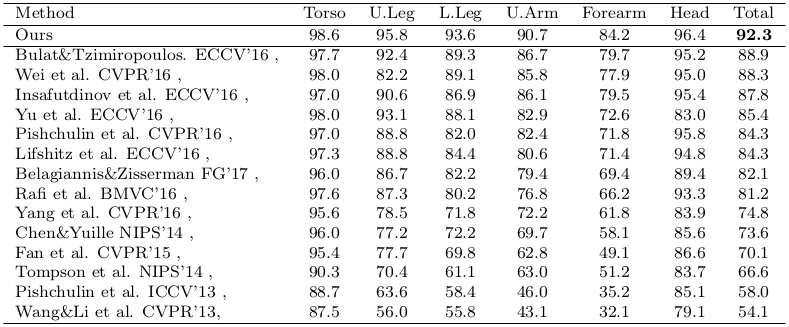
Table from the paper: Knowledge-Guided Deep Fractal Neural Networks for Human Pose Estimation
Table text:
Method
Torso
U.Leg
L.Leg
U.Arm
Forearm
Head
Total
Ours
98.6
95.8
93.6
90.7
84.2
96.4
92.3
Bulat&Tzimiropoulos. ECCV’16 ,
97.7
92.4
89.3
86.7
79.7
95.2
88.9
Wei et al. CVPR’16 ,
98.0
82.2
89.1
85.8
77.9
95.0
88.3
Insafutdinov et al. ECCV’16 ,
97.0
90.6
86.9
86.1
79.5
95.4
87.8
Yu et al. ECCV’16 ,
98.0
93.1
88.1
82.9
72.6
83.0
85.4
Pishchulin et al. CVPR’16 ,
97.0
88.8
82.0
82.4
71.8
95.8
84.3
Lifshitz et al. ECCV’16 ,
97.3
88.8
84.4
80.6
71.4
94.8
84.3
Belagiannis&Zisserman FG’17 ,
96.0
86.7
82.2
79.4
69.4
89.4
82.1
Raﬁ et al. BMVC’16 ,
97.6
87.3
80.2
76.8
66.2
93.3
81.2
Yang et al. CVPR’16 ,
95.6
78.5
71.8
72.2
61.8
83.9
74.8
Chen&Yuille NIPS’14 ,
96.0
77.2
72.2
69.7
58.1
85.6
73.6
Fan et al. CVPR’15 ,
95.4
77.7
69.8
62.8
49.1
86.6
70.1
Tompson et al. NIPS’14 ,
90.3
70.4
61.1
63.0
51.2
83.7
66.6
Pishchulin et al. ICCV’13 ,
88.7
63.6
58.4
46.0
35.2
85.1
58.0
Wang&Li et al. CVPR’13,
87.5
56.0
55.8
43.1
32.1
79.1
54.1